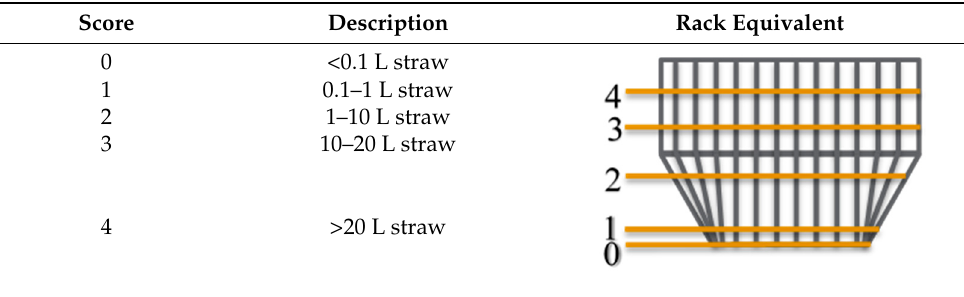
Table 2. Scoring system used to assess tail length (L0–L2) and tail damage (D0–D4) [21]